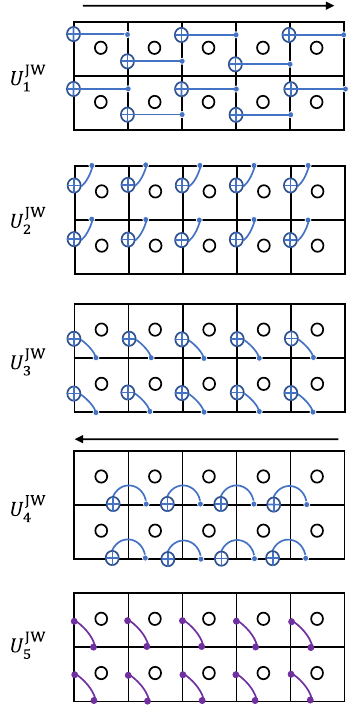
FIG. 22. The finite-depth Clifford circuit to convert the exact bosonization to the 1d Jordan-Wigner transformation. In the first step, we order the system from left to right, then apply the CNOT gate to each column following the above ordering. The CNOT gates are applied simultaneously in the second and third steps. In the fourth step, we order the system from right to left, then apply the CNOT gate to each column following the right-to-left ordering. In the fifth step, CZ gates are simultaneously applied. , U JW , U JW , U JW , U JW (from top to The depicted unitaries are U JW 5 1 2 3 4 . bottom). The GLU disentangler is U JW = U JW U JW U JW U JW U JW 5 4 3 2 1 and U JW are linear-depth local unitary Note that U JW 1 4